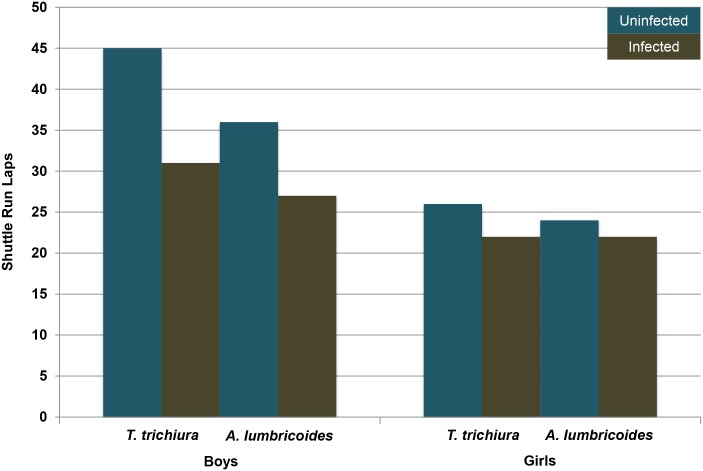
Infection with two common NTD parasites compromises boys’ fitness more strongly than that of girls.The results are based on the commonly used shuttle run measure, whereby fitness is determined by the number of 20-meter back-and-forth laps that can be completed in a fixed amount of time. The figure is based on data (combined across children and adolescents) presented in [101].